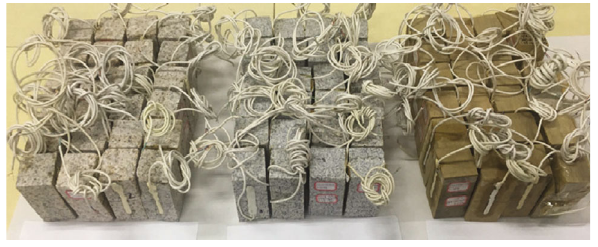
Figure 4: Granite and sandstone samples.